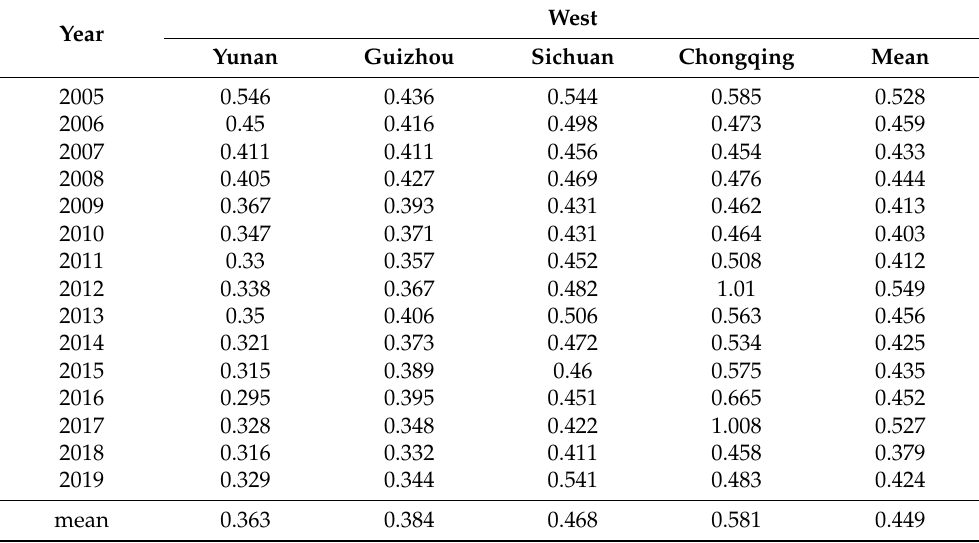
Table 2. GTFP in all provinces/municipalities of the